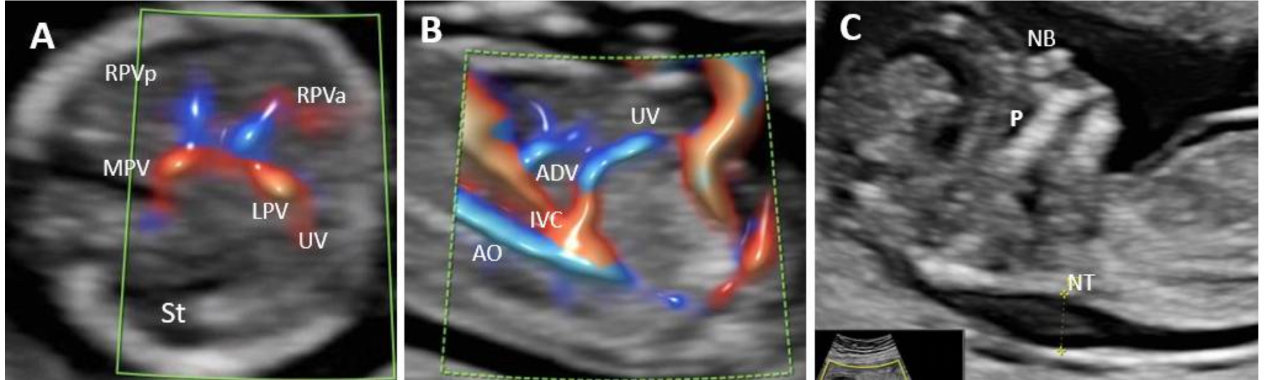
Figure 3. Agenesis of ductus venosus (ADV) in a first trimester case with umbilical vein drainage into inferior vena cava (IVC) and increased nuchal translucency. ( A ): Transverse plane of the FT fetal abdomen, with high-definition directional power Doppler applied. An ”H”-shaped variant of the intrahepatic portal veins connection is identified; ( B ): high-definition directional power Doppler in the sagittal plane of the fetal abdomen (same case) showing ADV with umbilical vein drainage into the inferior vena cava; ( C ): mid-sagittal view of the fetal face with the measurement of the thickened NT. MPV main portal vein, St stomach, LPV left portal vein, UV umbilical vein, RPVa anterior branch of right portal vein, RPVp posterior branch of right portal vein, Ao aorta, IVC inferior vena cava, ADV ductus venosus agenesis, P palate, NB nasal bone, NT nuchal